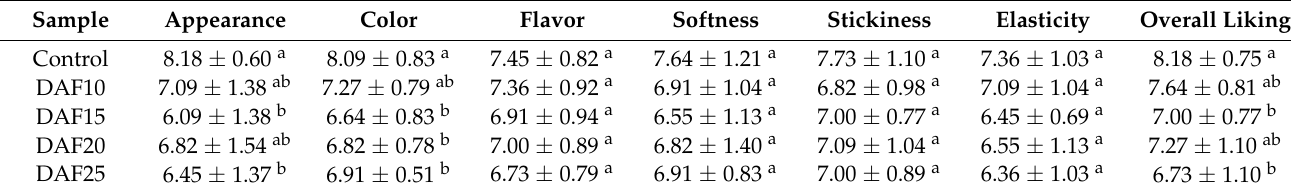
Table 7. Sensory characteristics of fresh wheat noodles with different substitution levels a,b